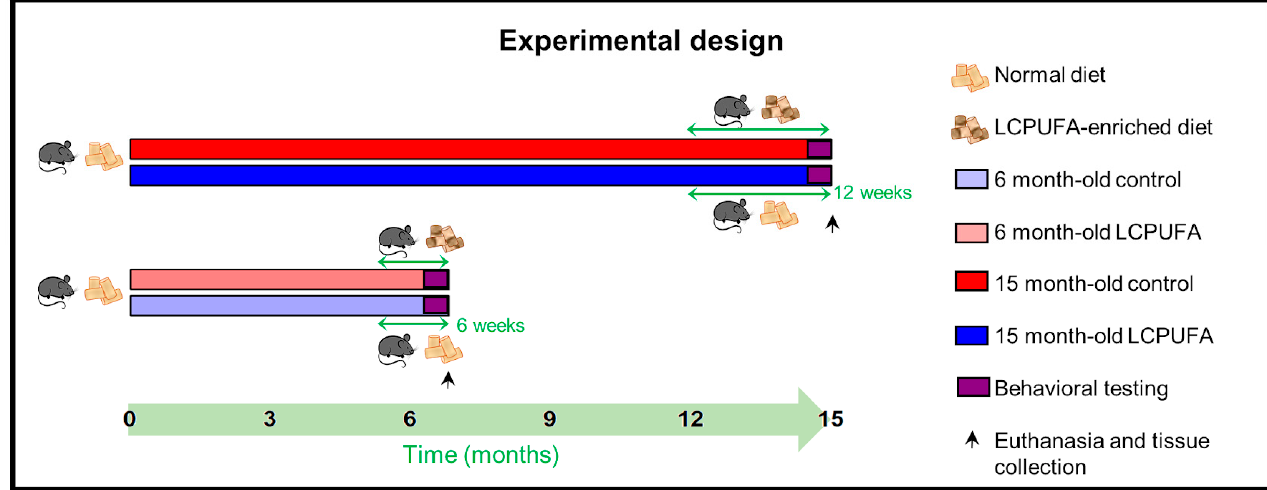
Table 2. Nutritive content of the standard and n-3 LCPUFA-enriched